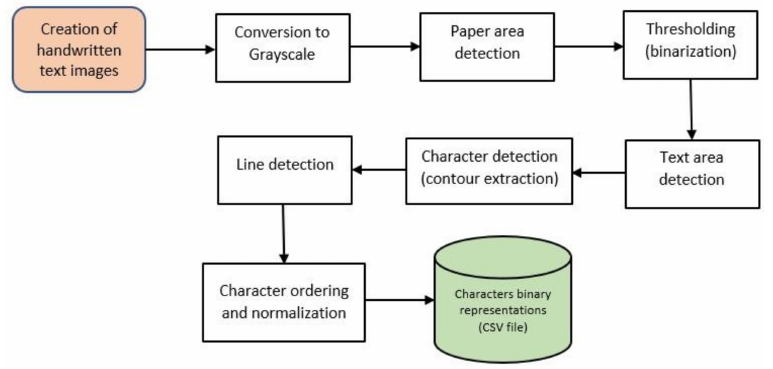
Figure 1. Image processing